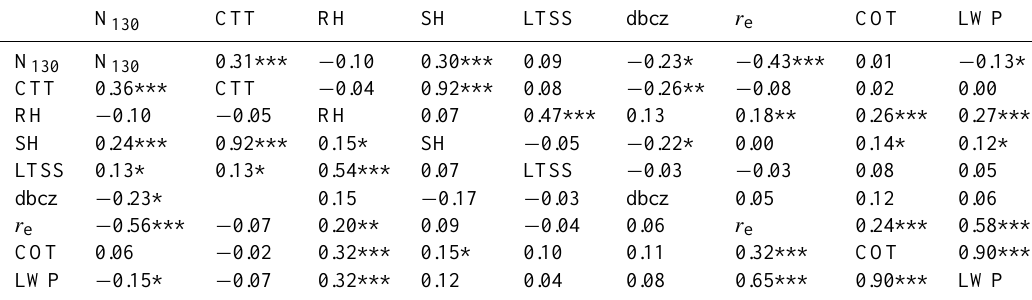
Table 5. Linear correlation coefficients for the data set from Hyytiälä (top right) and logarithmic correlation coefficients (bottom left). The logarithm has not been applied to the CTT and dbcz parameters since these contain mainly negative values. The stars indicate at what confidence level ( ∗ is 95%, ∗∗ is 99%, and ∗∗∗ is 99.9%) the correlation coefficients are significant. The parameters are the same as in Table